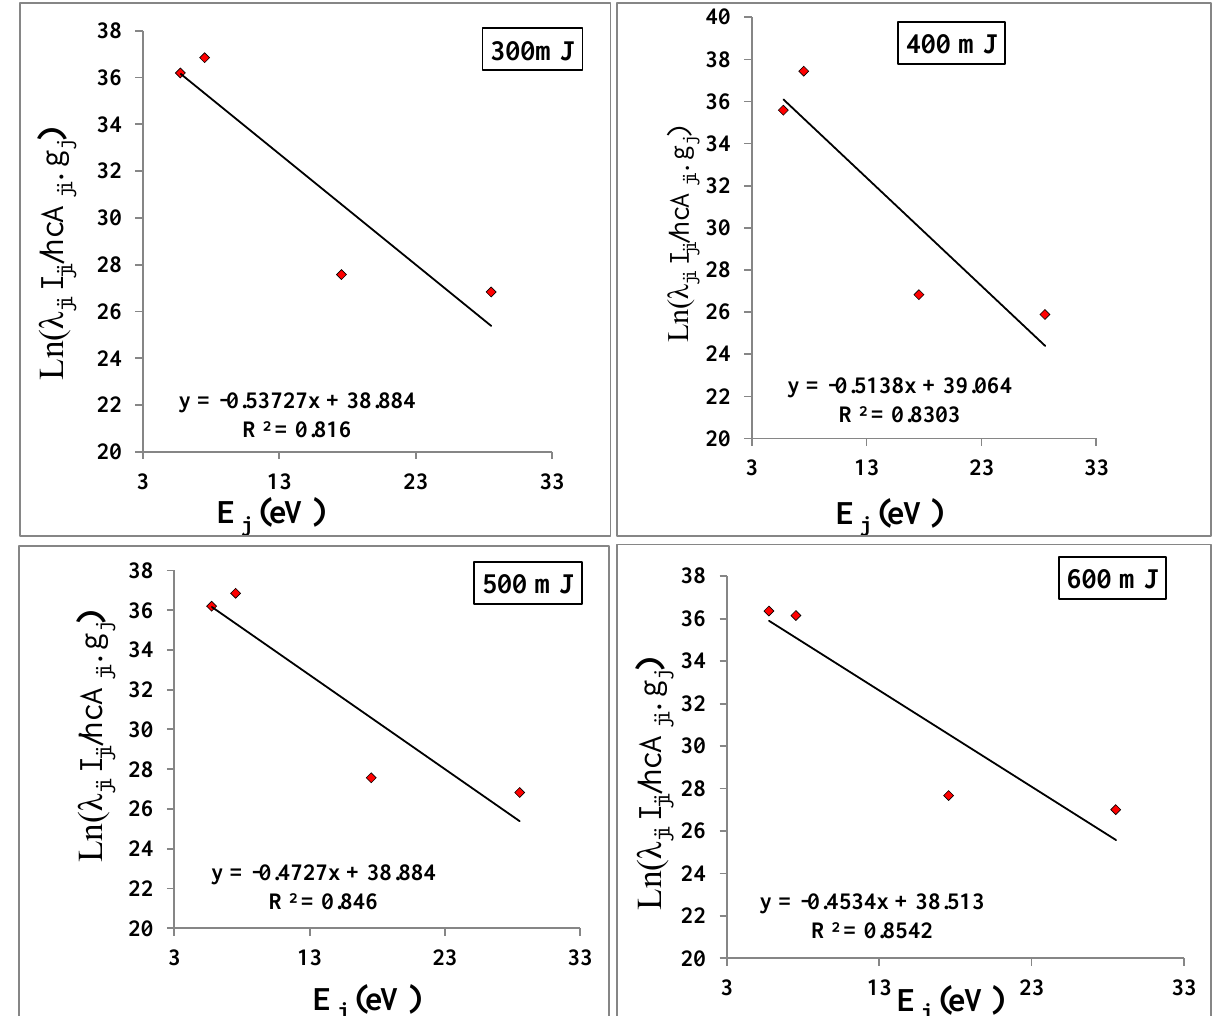
Figure 5: Boltzmann plots of Indian costus targets with different laser energies in the air.